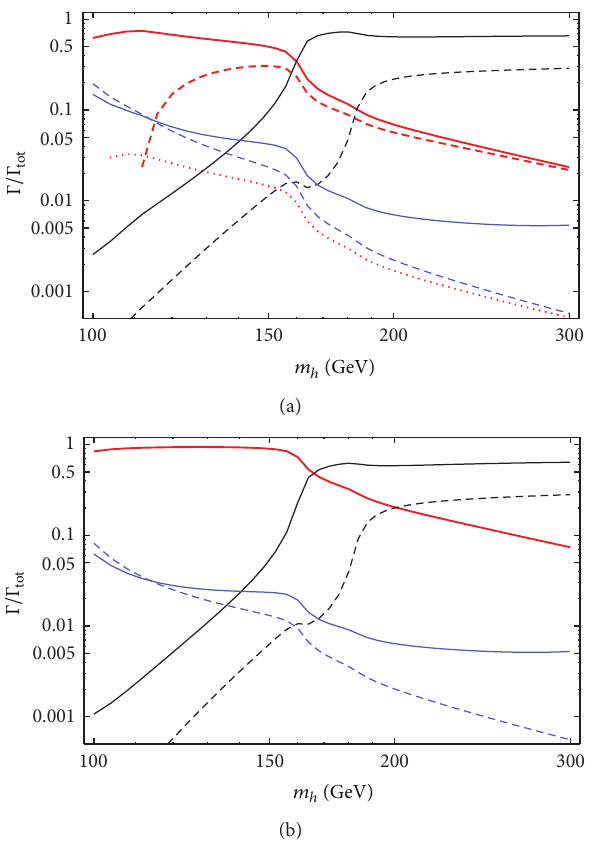
Figure 12: (a) Branching ratio of ℎ → 𝐷𝐷 as a function of 𝑚 𝐷 in SM4+D for 𝑚 ℎ = 115, 150, 200, 450 GeV. (b) The corresponding reduction factor R . The black-dotted portions are disallowed by direct search limits. Plots from